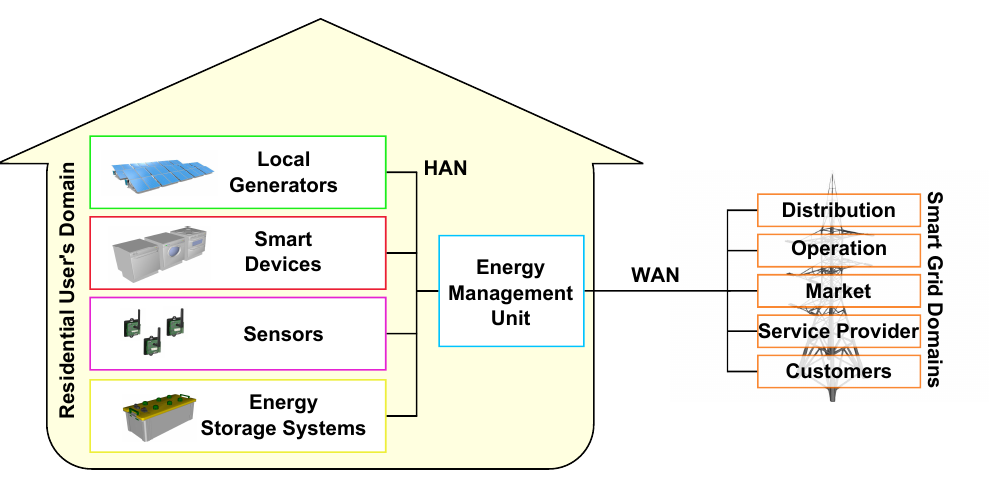
Figure 1. Architecture of demand-side management